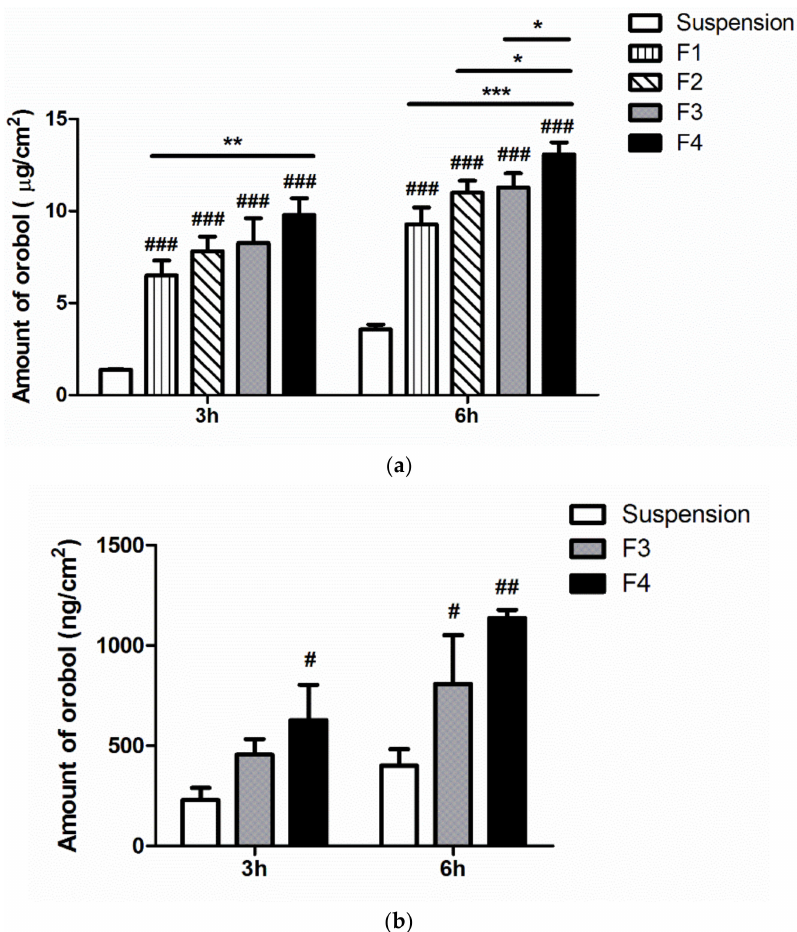
Figure 6. In vitro deposition of orobol into ( a ) Strat-M membranes and ( b ) human cadaver skin after applying the orobol-loaded SLNs and NLCs formulations (F1–F4) or orobol suspension in deionized water (DW) at a concentration of 0.5 mg / mL of orobol for 3 h and 6 h. Significantly di ff erent from one another at * p < 0.05, ** p < 0.01, and *** p < 0.001; Significantly di ff erent from the suspension group at # p < 0.05, ## p < 0.01, and ### p < 0.001.